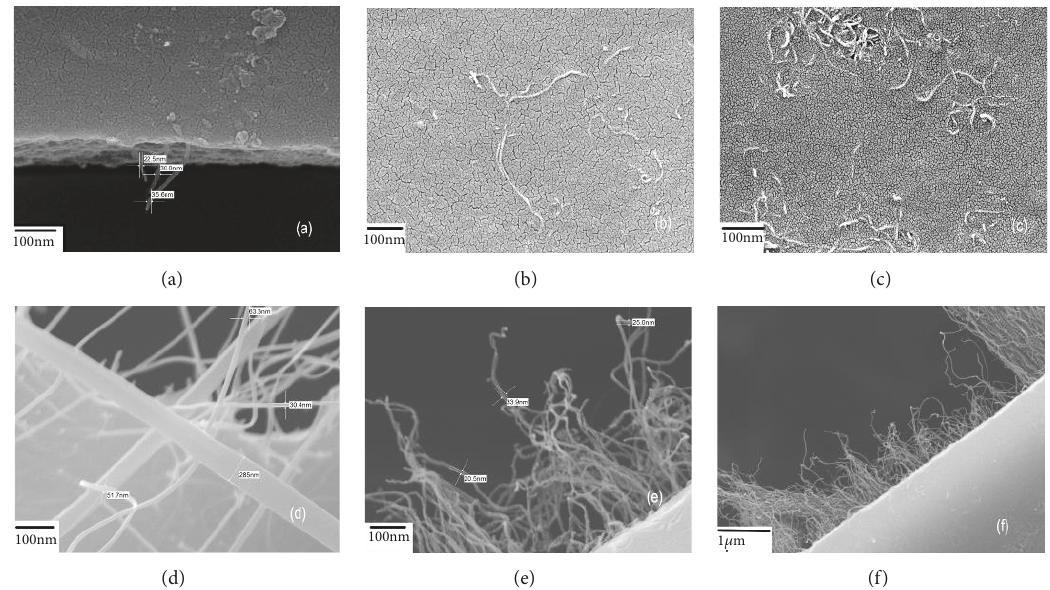
Figure 4: FESEM images of (a) MWCNT-PEDOT:PSS film from the side view showing MWCNT with different diameter, (b) MWCNT at 0.025 wt%, (c) MWCNT at 0.075 wt%, (d) MWCNT at 43,000 magnification, (e) MWCNT at 35,000 magnification, (f) MWCNT at 14,000 magnification.